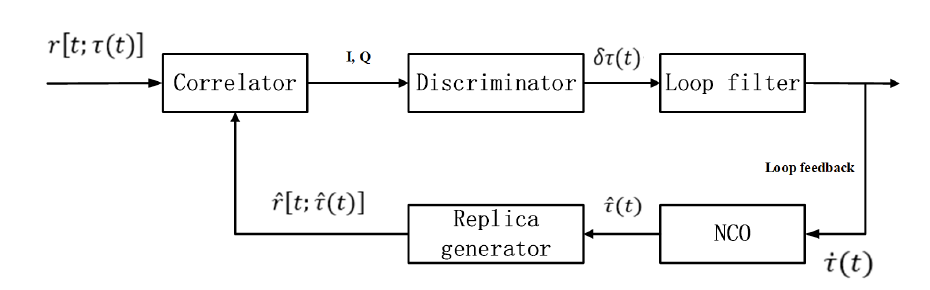
Figure 1. Linear model of a delay locked loop (DLL)-based code tracking loop under the time